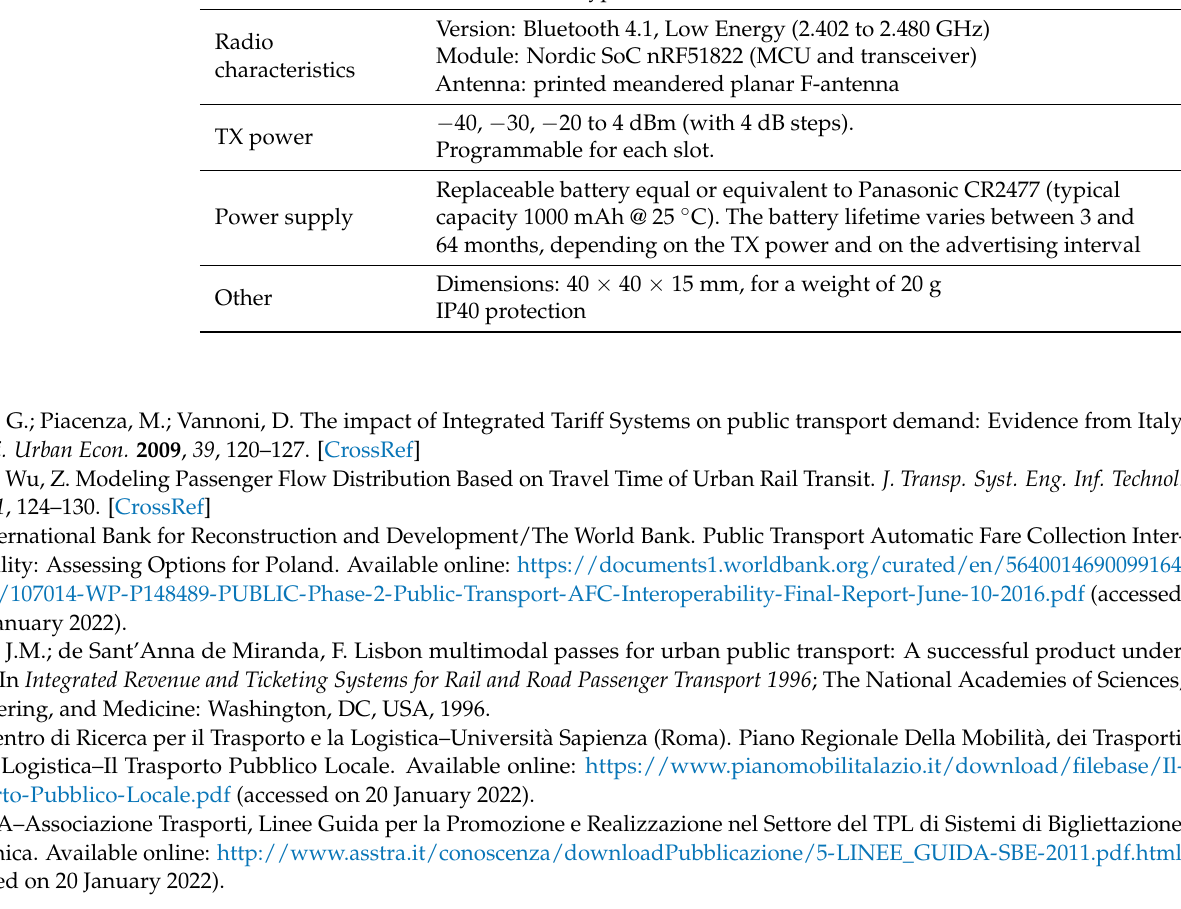
Table A1. System setting variables used during the experimentation. Four slots are configurable for Eddystone frame types (UID, URL, TLM, Configurable slots EID) and the latter four slots are configurable for iBeacon, Quuppa, and Sensors frame